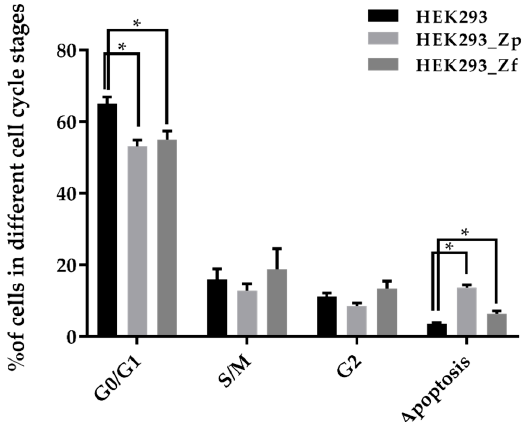
Figure 4. Summary of different cell cycle stages of HEK293 cells with or without persistent PRV and FLR strains of ZIKV infection. The error bars represent the triplicate for each measurement conducted at each time point of the study. Mean ± SD of each condition was calculated and the significance of the difference among and between groups was tested analyzed by ANOVA and student t -test. * student t -test analysis, p < 0.05. G0 / G1: Gap 0 / Gap 1 phase; S / M: DNA Synthesis / Mitosis phase; G2: Gap 2